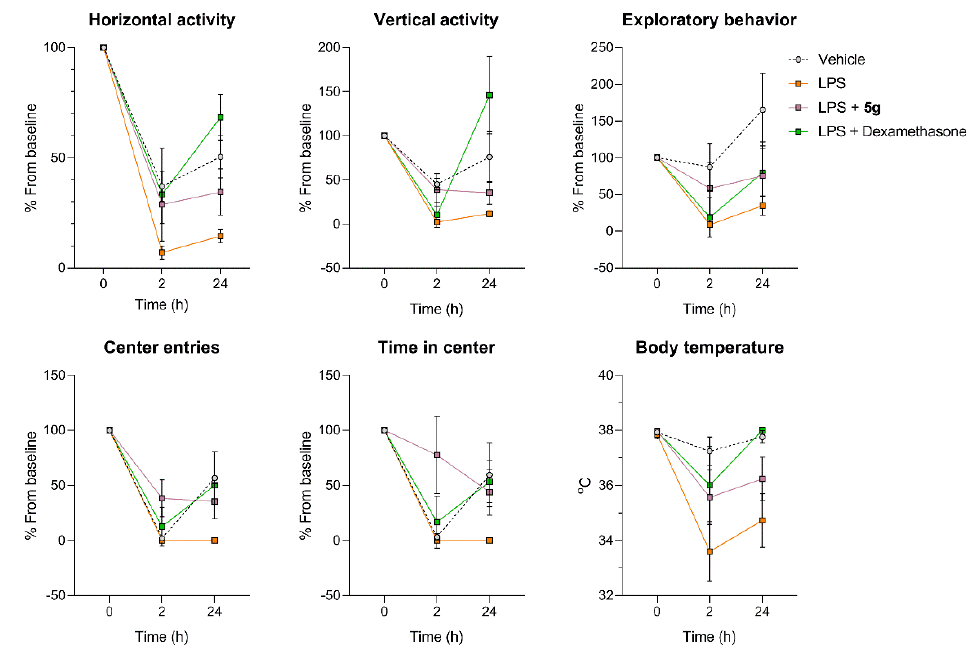
Figure 5. The motor activity of the mice in the open field test. Data are shown as mean ± SD.